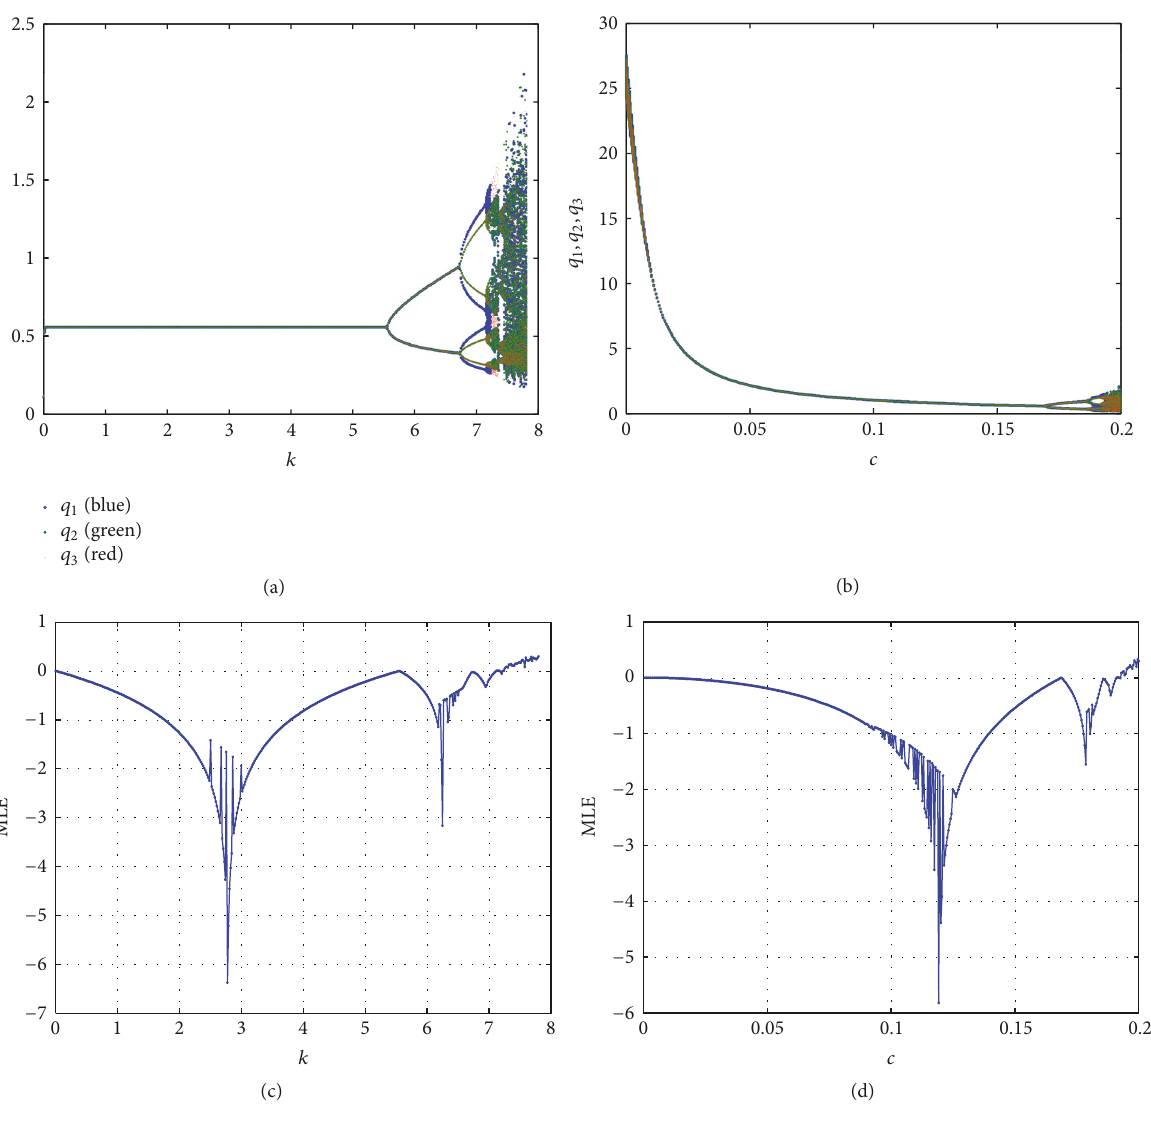
Figure 8: (a) Bifurcation diagram for the symmetric case of system (10) at 𝑐 = 0.2 , 𝑞 0,1 = 0.11 , 𝑞 0,2 = 0.12 , and 𝑞 3,0 = 0.13 . (b) Bifurcation diagram for the symmetric case of system (10) at 𝑘 = 7.8 , 𝑞 0,1 = 0.11 , 𝑞 0,2 = 0.12 , and 𝑞 3,0 = 0.13 . (c) The maximum Lyapunov exponents with respect to 𝑘 . (d) The maximum Lyapunov exponents with respect to 𝑐